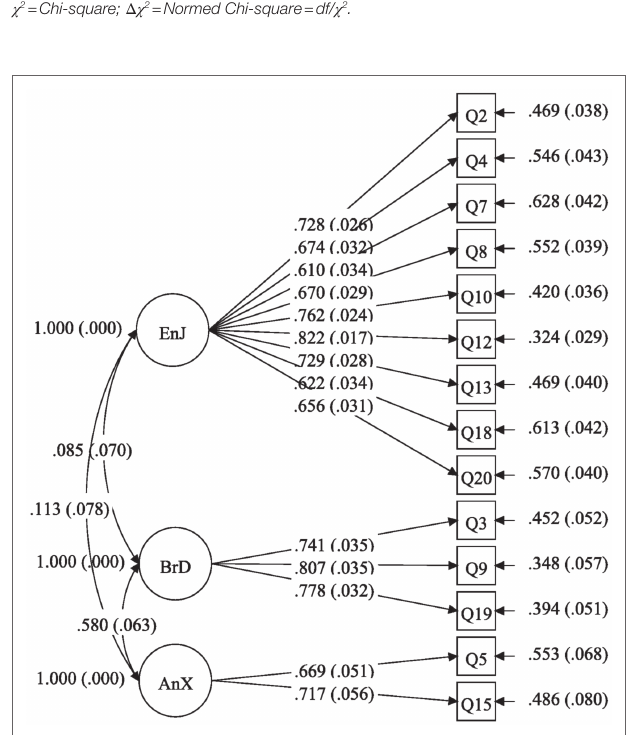
FIGURE 1 | The three-factor model of foreign language flow.